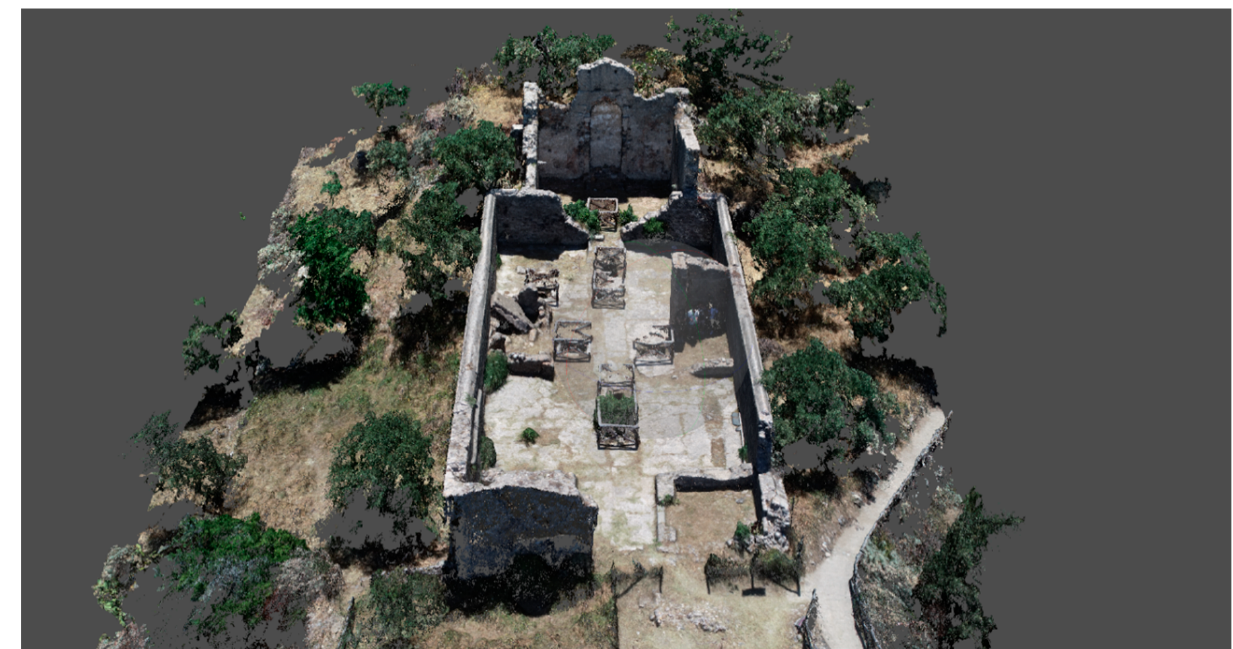
Figure 18. 3D Topographic model of the site derived from UAV photogrammetry.